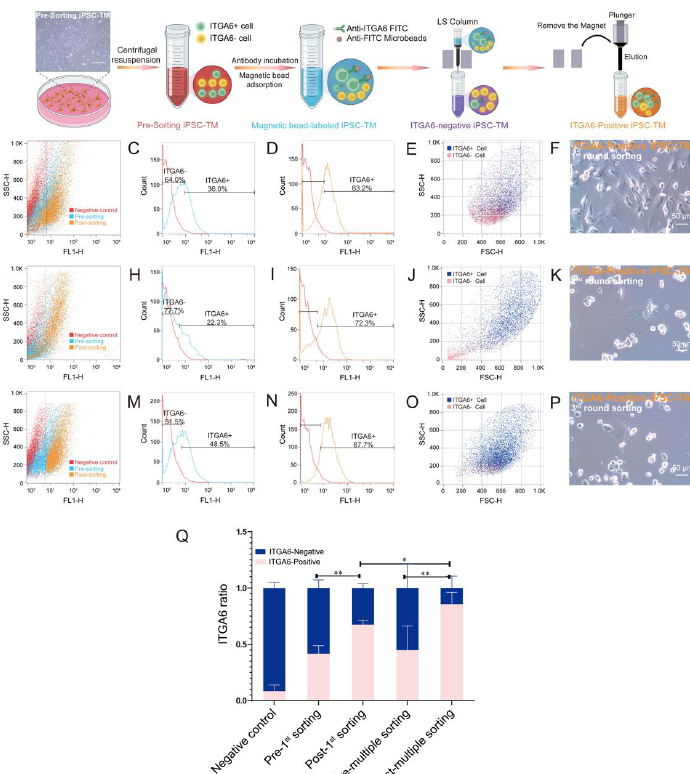
Figure 2. The magnetic platform to purify ITGA6-positive iPSC-TM. ( A ) Schematic illustration of the ITGA6-positive iPSC-TM purification process. The unlabeled iPSC-TM cells in the red tube were the negative control. iPSC-TM cells after labeling with FITC-conjugated anti-ITGA6 antibodies and anti-FITC microbeads were collected in a blue tube. ITGA6-negative iPSC-TM after the LS- based purification was collected in a purple tube, while ITGA6-positive iPSC-TM after the LS-based purification was collected in an orange tube. ( B ) A fluorescence density plot (FL1-H vs. SSC-H) depicting the distribution of the negative control cells (red), pre-first sorting cells (blue), and post-first sorting cells (orange). Each dot indicates an individual cell. ( C , D ) Histogram analyses of the negative control cells (red), pre-first sorting (blue) cells, and post-first sorting (orange) cells. The ratios of ITGA6-positive cells and ITGA6-negative cells are labeled in each plot. ( E ) A plot (FSC-H vs. SSC-H) indicating the distributions of the ITGA6-positive cells (blue) and ITGA6-negative cells (pink) in the post-first sorting samples. Each dot represents an individual cell. ( F ) A representative image showing the morphology of the ITGA6-positive iPSC-TM after one round of LS-based sorting. ( G – J ) Similar to panels ( B – E ) showing the flow cytometry results after two rounds of LS-based sorting. ( K ) An image showing the morphology of ITGA6-positive iPSC-TM after the second round of cell sorting. ( L – O ) Similar to panels ( B – E ) showing the flow cytometry results after three rounds of LS-based sorting. ( P ) An image showing the morphology of ITGA6-positive iPSC-TM after the third round of cell sorting. Scale bars, 50 µ m. ( Q ) Quantification analysis of the ratios of ITGA6-positive cells (pink) and ITGA6-negative cells (blue) based on 3–6 experimental repeats. LS-based purification significantly increased the ratios of the ITGA6-positive cells (pre-first sorting vs. post-first sorting: 0.42 ± 0.042 vs. 0.68 ± 0.02, ** p < 0.01; pre-multiple sorting vs. post-multiple sorting: 0.45 ± 0.11 vs. 0.89 ± 0.05, ** p < 0.01). As the round of sorting increases, the ratio of ITGA6-positive cells